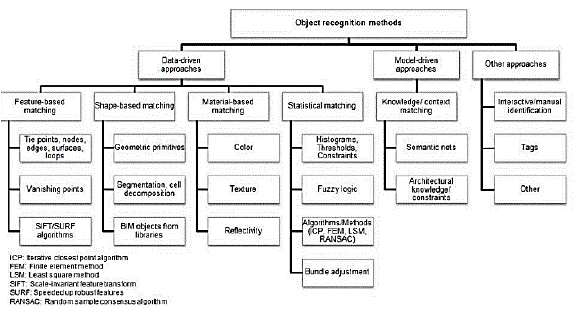
Figure 2. Summary of algorithms for object